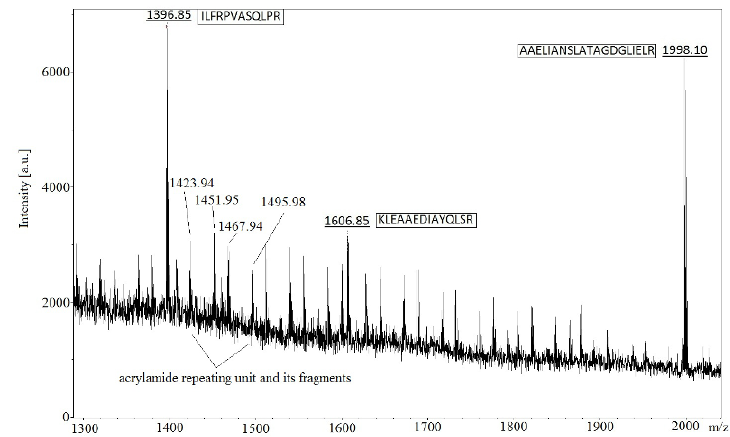
Figure 4. Detail of prohibition PMF spectrum with the repeating acrylamide monomer units and its fragments. Underlined masses are peptides of prohibition origin.